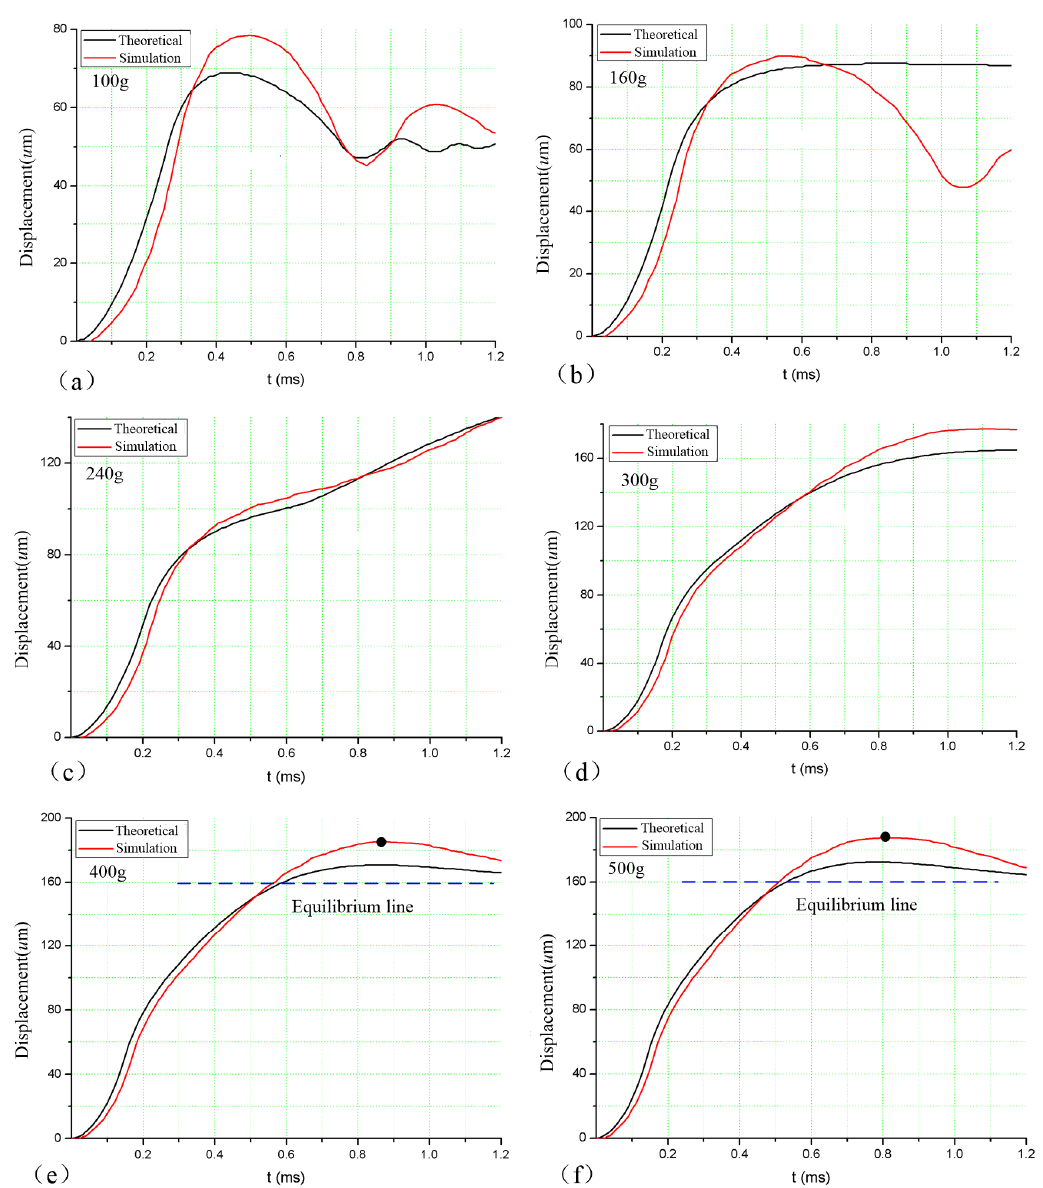
Figure 5. Comparison of theoretical and simulation curves. ( a ) under load of 100 g; ( b ) under load of 160 g; ( c ) under load of 240 g; ( d ) under load of 300 g; ( e ) under load of 400 g; ( f ) under load of 500 g.